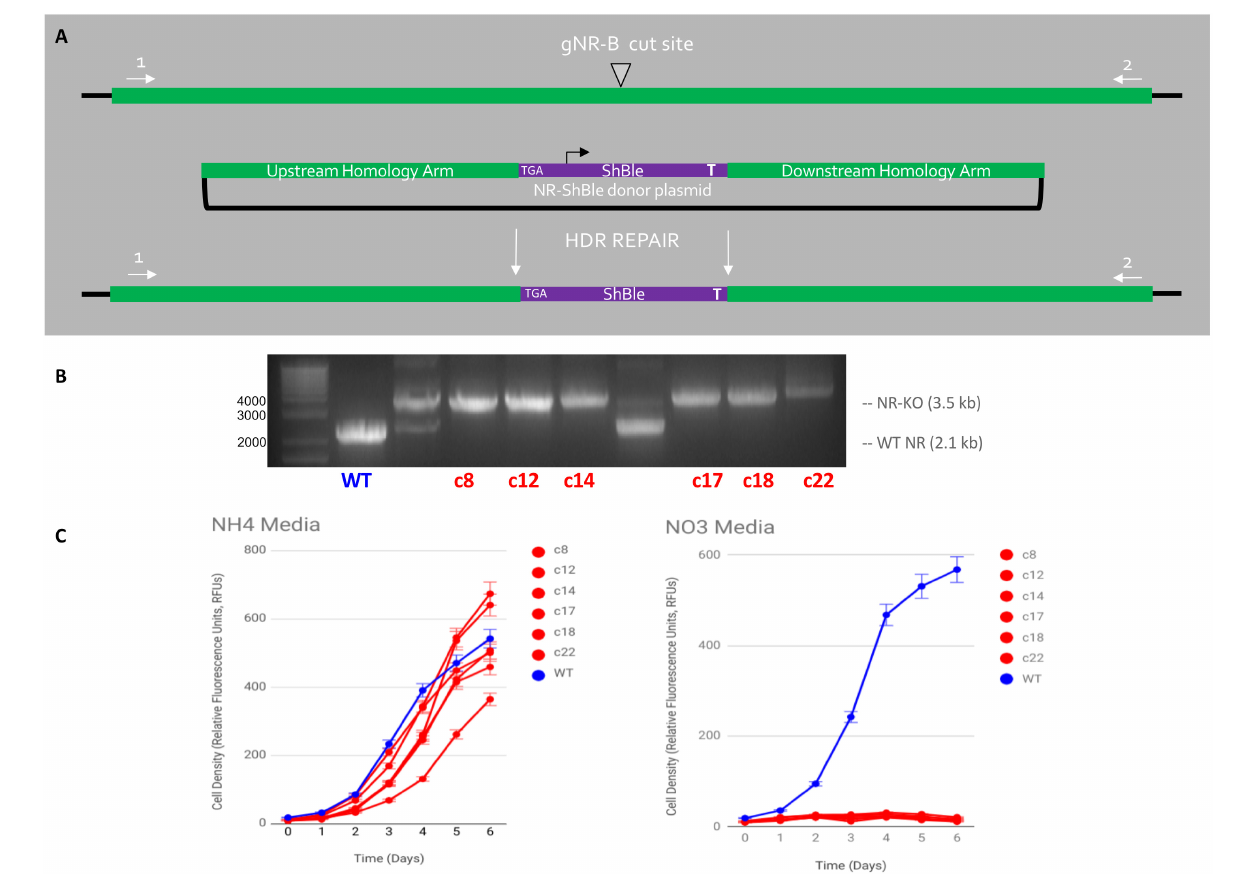
FIGURE 5 | HDR-mediated CRISPR-Cas9 targeted insertion of Sh ble gene via micro-particle bombardment genetic transformation. (A) An sh ble expression cassette with an upstream premature STOP codon was precisely inserted at the gNR-B DSB site Cas9, gNR-B, and a NR-Sh ble donor plasmid were delivered to P. tricornutum cells on separate plasmids by micro-particle bombardment. The plasmids are presumably integrated within genomic DNA and the CRISPR components are expressed from P. tricornutum chromosomes. (B) An electrophoresis gel shows migrated amplicon from six mutants target loci compared to a wild-type NR locus. A single band, rather than two or more, indicated a bi-allelic HDR-mediated edit of the gNR-B target. (C) All six mutant cell lines could not grow on nitrate-supplemented media compared to wild-type but could grow on ammonium-supplemented media, a confirmation the predicted NR-KO mutant phenotype. All cell lines were grown in technical